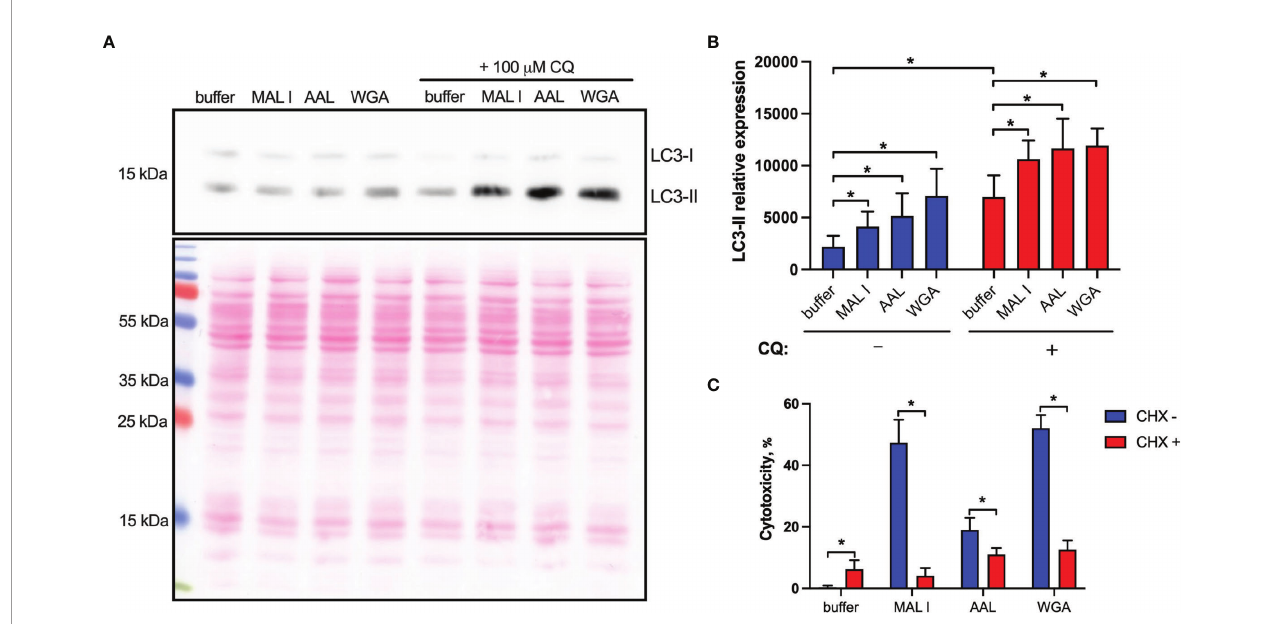
FIGURE 5 | Non-apoptotic effects of lectins in MC-38 cells. (A) Induction of autophagy in cells treated with lectins was measured by quantitative immunoblot analysis. MC-38 cells were treated with lectins with or without chloroquine (CQ) (100 m M) for 6 h followed by lysis with RIPA buffer and analysis by immunoblot staining. Chloroquine was added 4 h prior to cell lysis (B) Quanti fi cation of immunoblot data by densitometry image analysis using ImageJ software. LC3-II levels were quanti fi ed and normalized to total protein levels using Ponceau S staining. (C) Assessment of de novo protein synthesis requirement for cell death induction. MC-38 cells were treated with lectins either alone or in combination with cycloheximide (2.5 µg/ml) for 20 h followed by cytotoxicity measurement using LDH release assay. All data are from at least 6 replicates out of 2 independent experiments with four (B) or three (C) technical replicates each. *P < 0.05; unpaired two-tailed